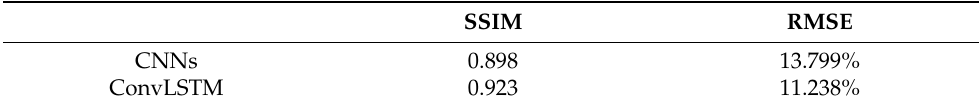
Figure 14. Comparison of the RMSEs of the iterative prediction by the CNNs and ConvLSTM. The magenta and blue lines represent the RMSE of ConvLSTM and CNNs, respectively. Table 5. Average SSIM and RMSE of the CNNs and ConvLSTM.